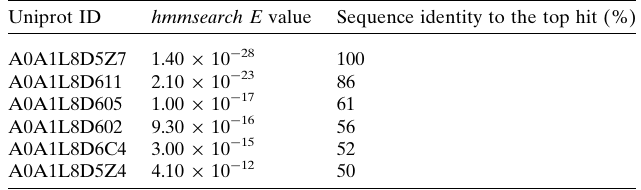
Table 1 Results of the sequence identification in B. atrox venom proteome using findMySequence and an ARP/wARP PLA2 model built without an input sequence.